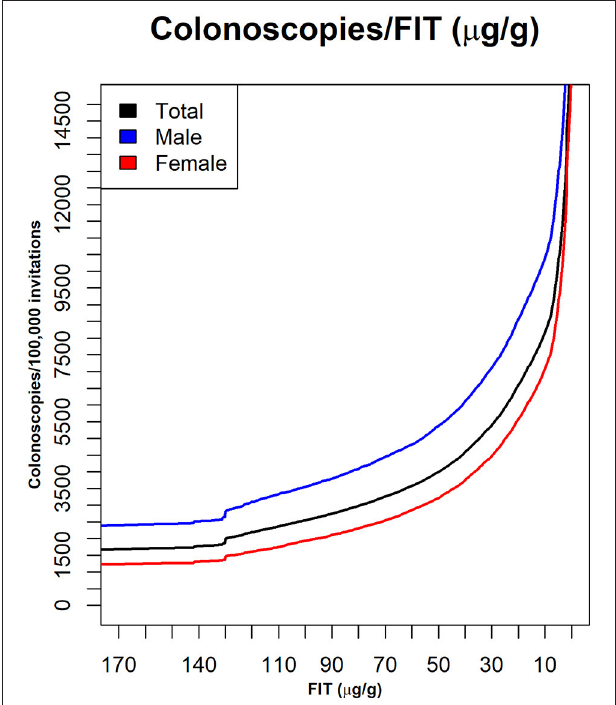
FIGURE 3 | The number of individuals with undiagnosed lesions, based on the indicated FIT cut-off points. Dark lines: the whole population (Overall); Different colors: different lesion risk classes; dashed and dotted lines: different sex groups for each lesion risk class; X axis: FIT: ( µ g hemoglobin/g feces). Y axis: the number of people with undiagnosed lesions per 100,000